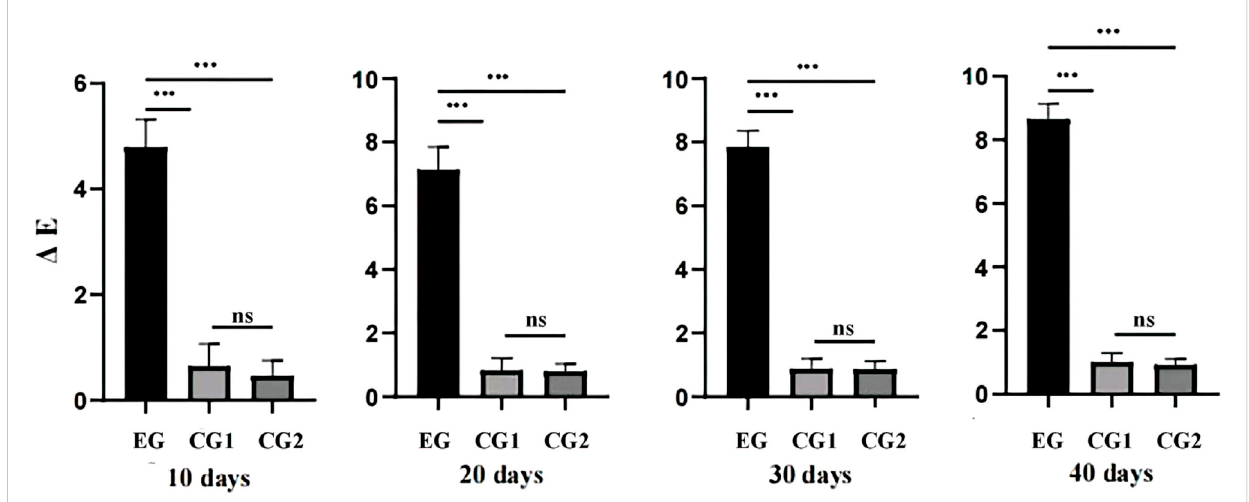
FIGURE 5 The trends for change in color difference ( Δ E ) in the three groups during bleaching for 40 days. EG refers to Experimental group; CG1refers to Conditional control group; CG2refers to Blank control group.